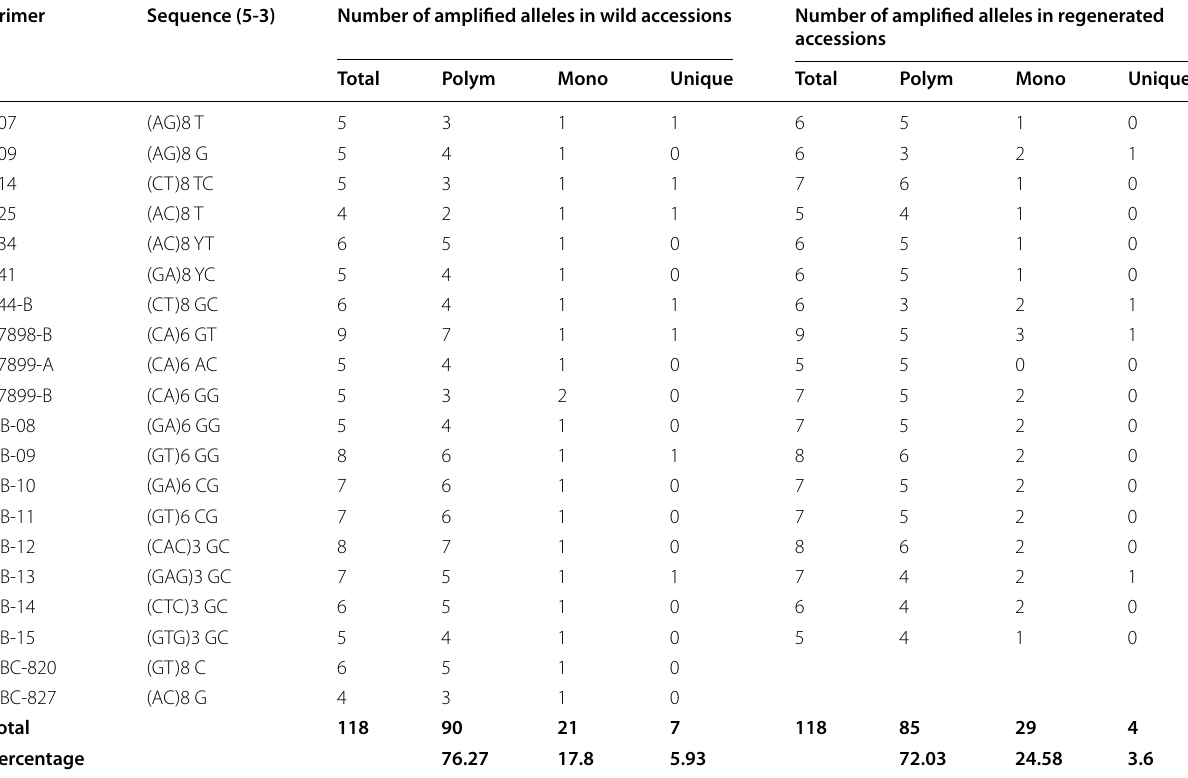
Table 3 Primers codes, sequences (Y monomorphic alleles (mono) unique alleles (unique) and % of total polymorphism induced in wild and regenerated accessions of A.